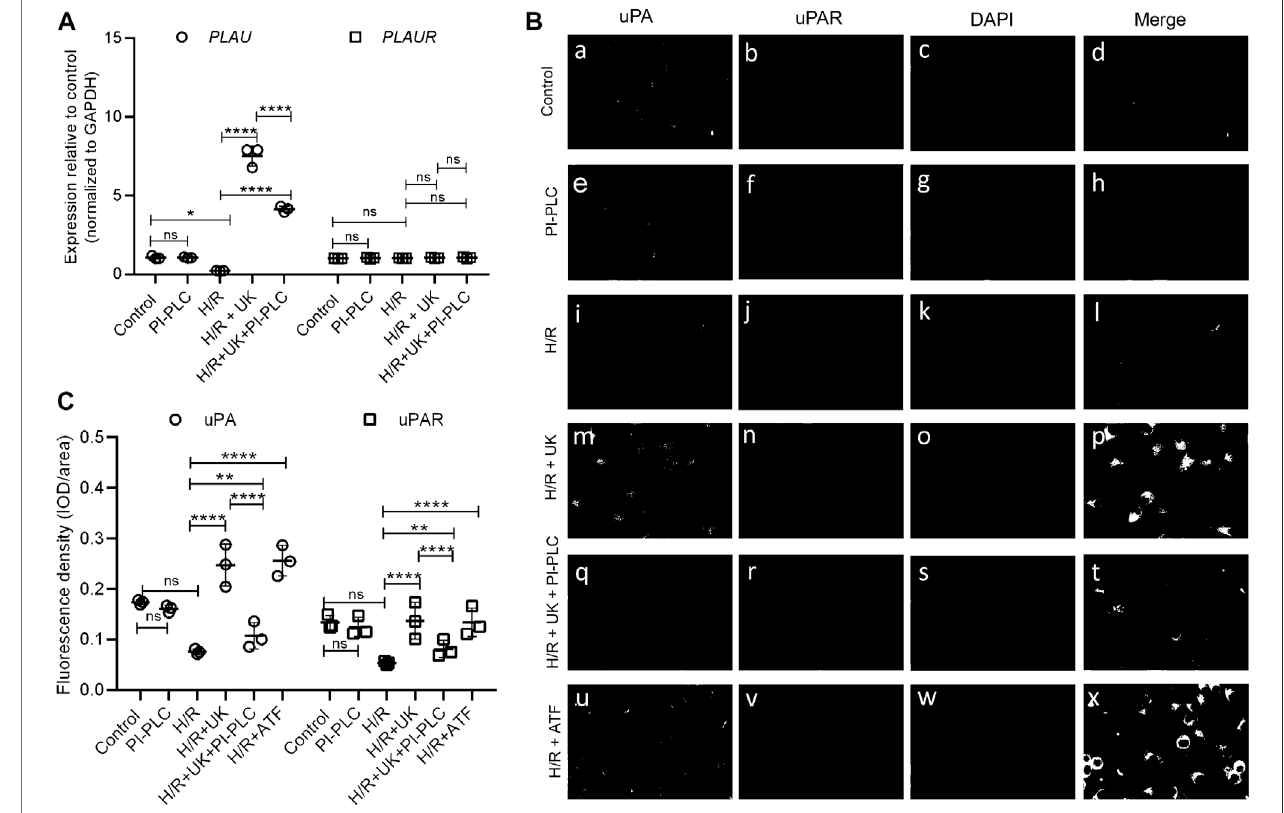
Frontiers in Pharmacology |